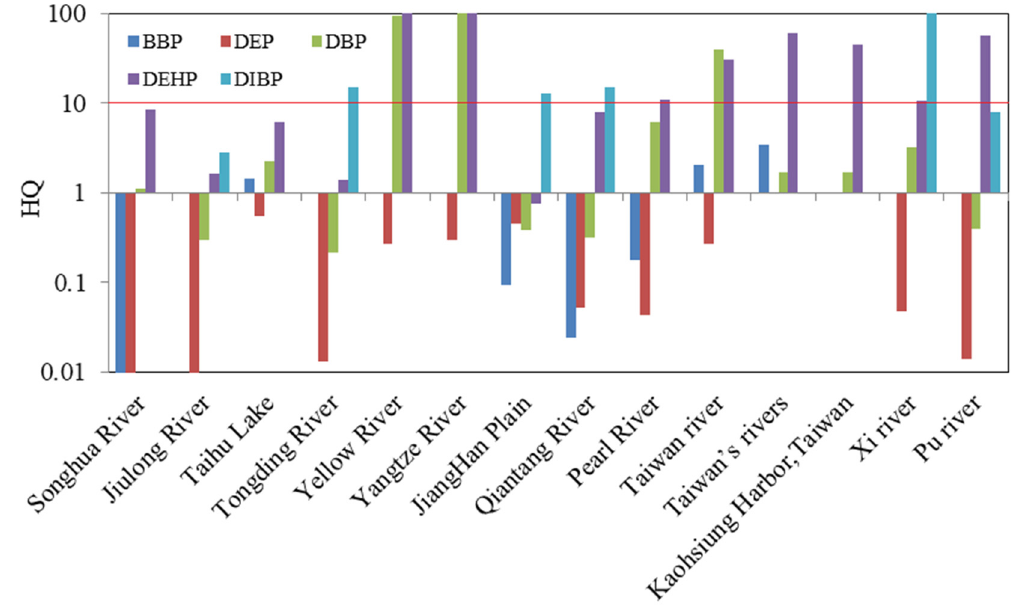
Figure 6. The preliminary ecological risks of ∑ 5 PAEs in typical rivers in China (in sediments).